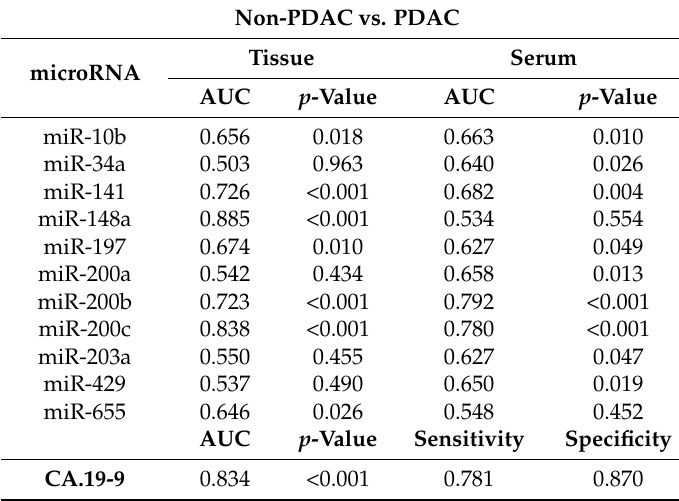
Table 2. Diagnostic performance of single EMT-miRs and CA.19-9 in discriminating PDAC from Non-PDAC. Values are calculated by ROC analysis. p ≤ 0.05 indicates